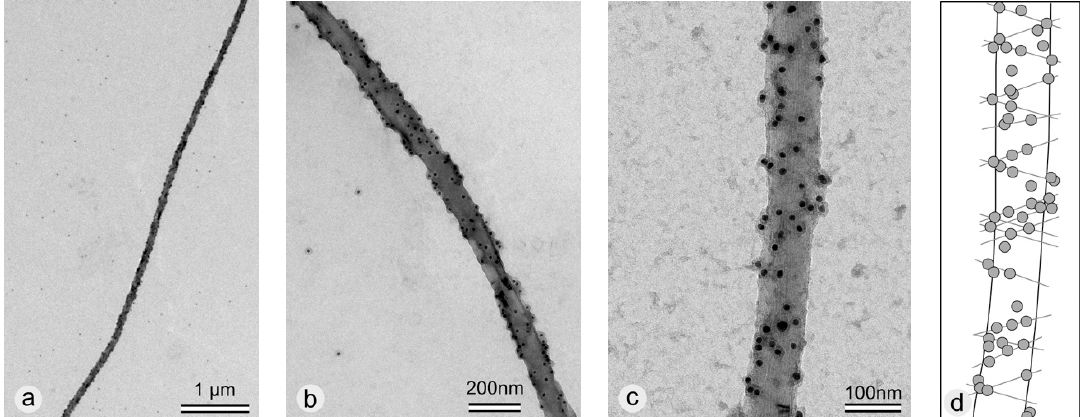
Figure 6. TEM images of immune gold labeled and negatively stained rSbpA 31-1068 GG coated -COOH functionalized MWNTs. ( a ) The S-layer and in this was the gold nanoparticles cover tens of micrometers on the MWNT surface. ( b , c ) The gold particles of the gold-labeled goat antibodies can be clearly seen. It seems that they are helically arranged along the tubes as schematically shown in ( d ) for ( c